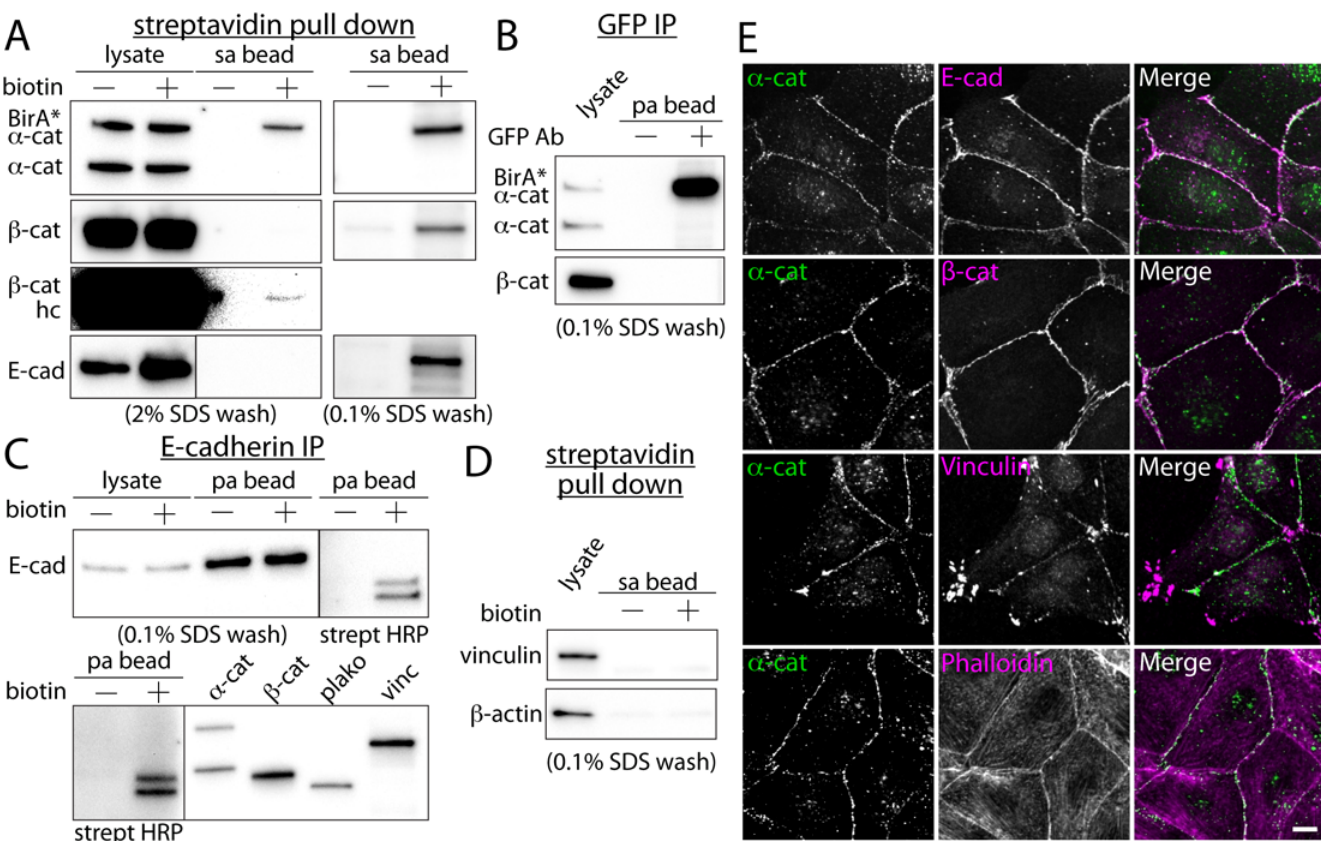
Fig 2. In situ proximal biotinylation by promiscuous BirA * - α -catenin. (A) Western blots of purified proteins from BirA * - α -catenin expressing cells using streptavidin-conjugated beads. E-cadherin (E-cad), β -catenin ( β -cat), vinculin and β -actin antibodies. Both 2% and 0.1% SDS wash conditions shown. The image contrast of β -catenin blot was enhanced to show the presence of β -catenin in the bead fraction ( β -cat hc). (B) Immuno-precipitation of GFP-tagged BirA * - α -catenin proteins using an anti-GFP antibody. The immuno-precipitaed samples were analyzed using Western blot with α -catenin and β -catenin antibodies. (C) Immuno-precipitation of E-cadherin from BirA * - α -catenin expressing cells using an E-cadherin antibody. From immuno-precipitaed proteins, two readily identifiable bands in the streptavidin blot had identical molecular weights as that of β -catenin and plakoglobin. (D) Western blots of strepavidin purified proteins using vinculin and β -actin antibodies. Vinculin and β -actin were not detected in the streptavidin purified protein pool. (E) Co-localization analysis of α -catenin and other cell-cell adhesion and cytoskeletal proteins. While E-cadherin, β -catenin, vinculin and actin filaments co-localize with α - catenin, only E-cadherin and β -catenin are biotinylated by BirA * - α -catenin. Scale bar 10 μ m.